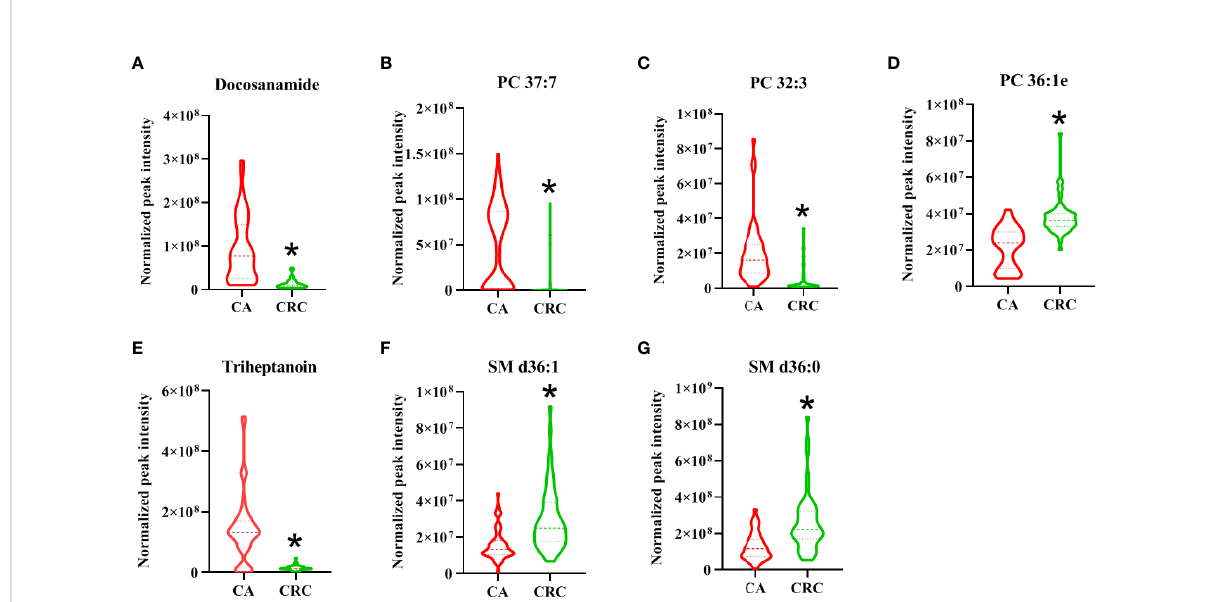
FIGURE 8 The change trend of seven differential lipid species with high performance for the discrimination of CA and CRC groups. The levels of differential lipid species between CA and CRC groups were displayed with mean ± SEM. The “ ★ ” represented statistical signi fi cance of the variate with P < 0.05 between two groups. Among them, the levels of differential lipids of Docosanamide (A) , PC 37:7 (B) , PC 32:3 (C) , and Triheptanoin (E) showed signi fi cant decrease, whereas those of PC 36:1e (D) , SM d36:1 (F) , and SM d36:0 (G) exhibited obvious increase in the patients with CRC compared to patients with